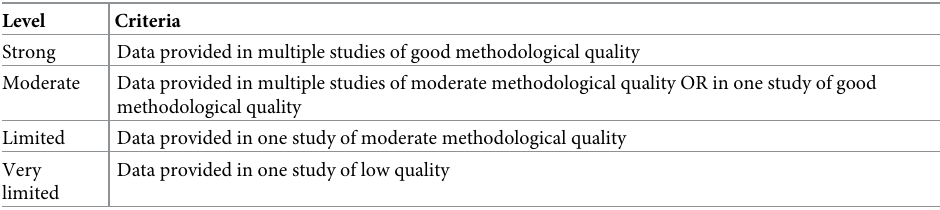
Table 1. Criteria for reporting methodological quality and consistency (adjusted from the criteria provided by van Tulder et